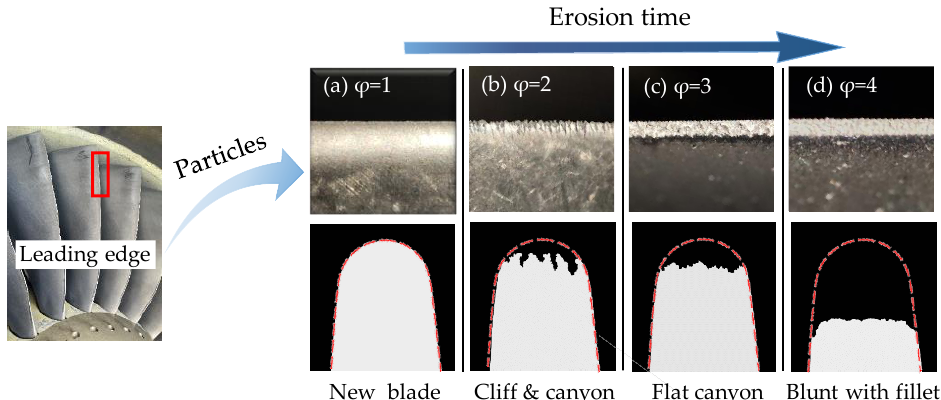
Figure 4. The erosion evolution process of the fan blades’ leading